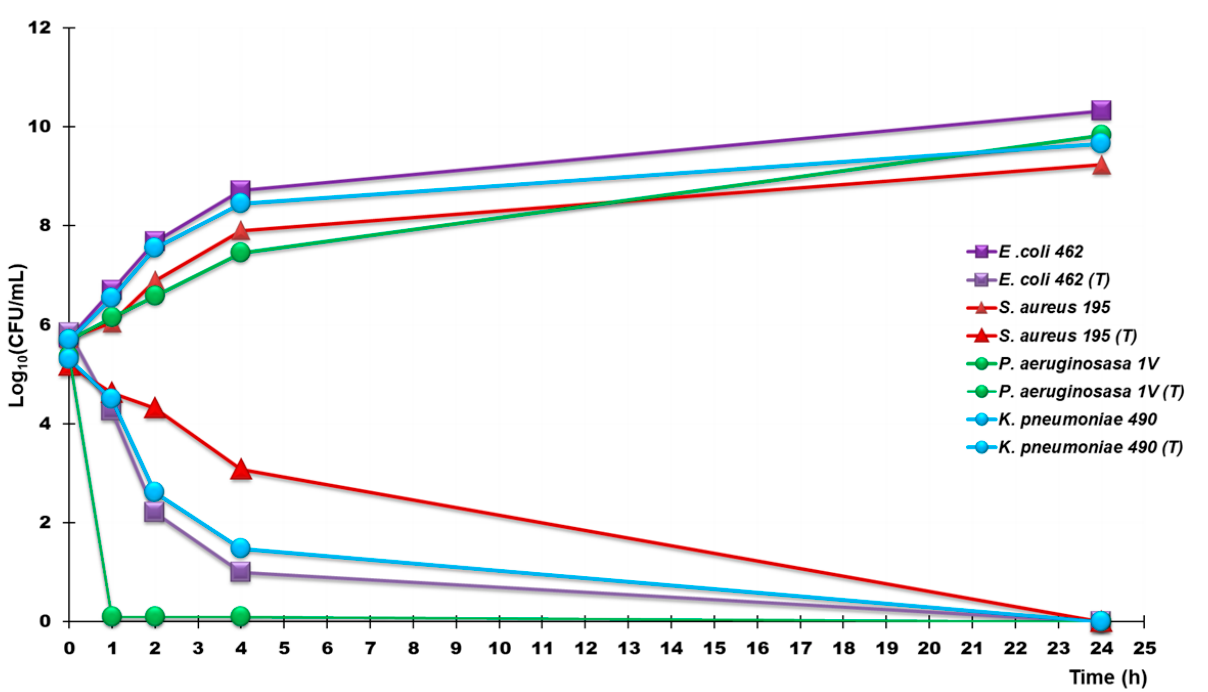
Figure 3. Time-killing curves performed with CB1H-P7 NPs (at concentrations equal to 4 × MIC) on P. aeruginosa 1V (green lines), E. coli 462 (purple lines), K. pneumoniae 490 (light blue lines), and S. aureus 195 (red lines). Square indicators denote control samples, while round indicators denote treated samples.